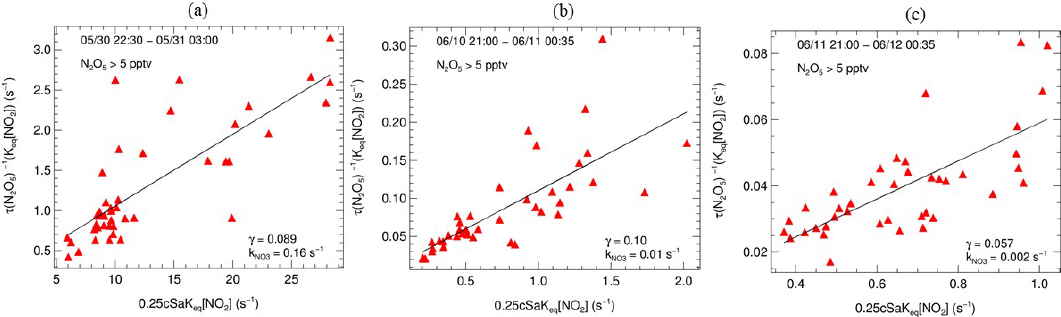
Figure 5. Derived N 2 O 5 uptake coefficients from N 2 O 5 steady lifetime ( γ _S) with NO 2 and S a ; plots (a–c) represent the linear fitting results on the nights of 30 May, 10 and 11 June,